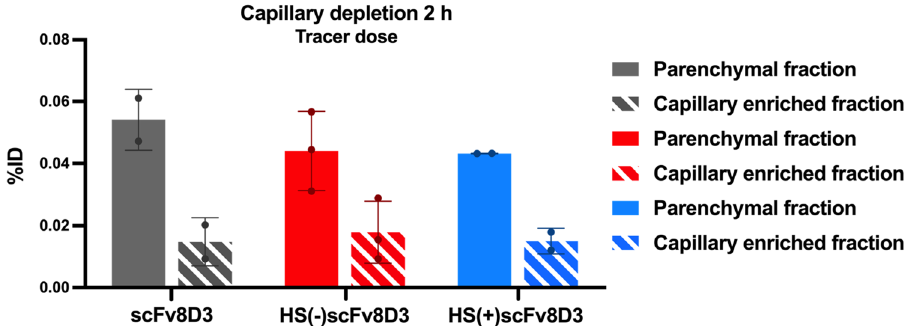
Figure 8. Signal distribution in brain parenchyma vs brain capillaries of [ 125 I]scFv constructs by capillary depletion. The CD results were attained from ex-vivo studies 2 h post injection of WT animals intravenously injected with tracer doses (0.3 nmol/kg) of [ 125 I]scFv8D3 (n = 2), the [ 125 I]HS(−)scFv8D3 mutant (n = 3) or the [ 125 I]HS(+)scFv8D3 mutant (n = 2). The CD results are presented as average radioactivity normalized to the injected dose (%ID) in